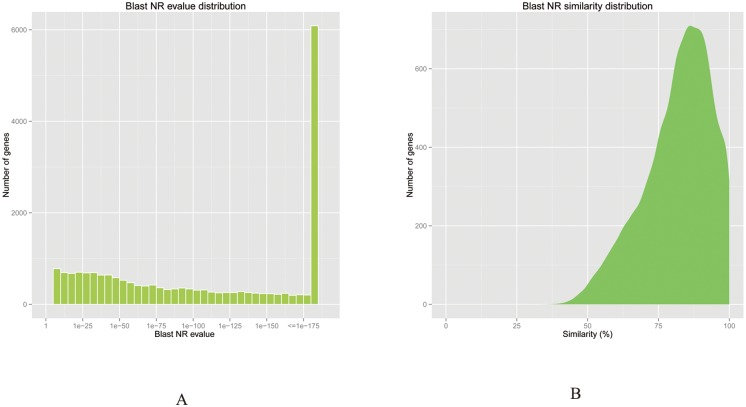

E-value and similarity distribution of sweet cherry fruit tissue transcriptome unigenes with annotation to the Nr database.(A) E-value distribution of annotated unigenes; (B) Similarity distribution of annotated unigenes.